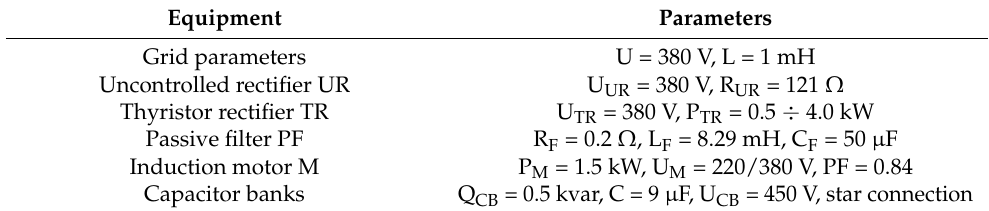
Table 3. The equipment parameters of the laboratory bench.